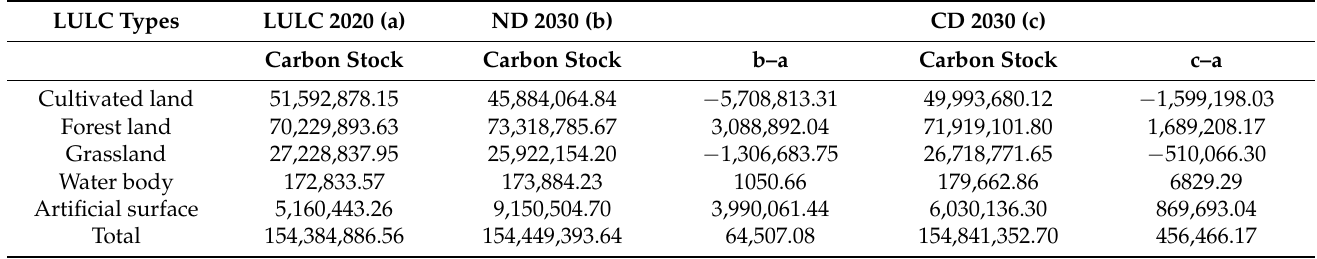
Table 5. Changes in carbon stocks for each LULC class from 2020 to